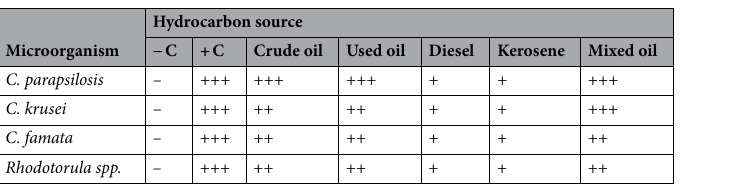
Table 1. Drop collapse assay for surfactants of the isolated strains of yeast. − C: negative control (culture broth), + C: positive control (Triton